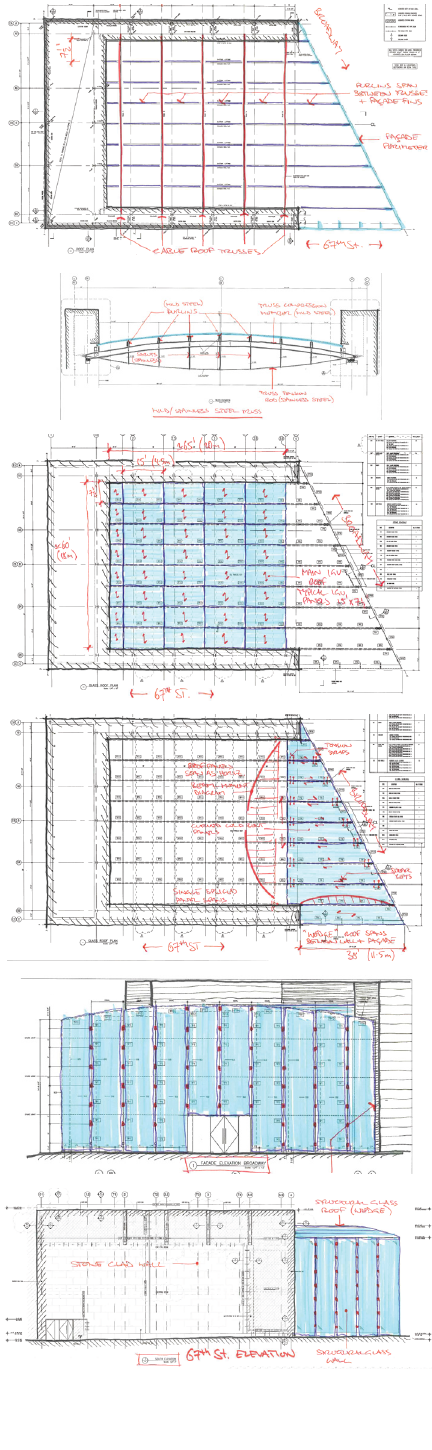
Figure 2: Structural plan. Steel trusses span 20m between the stone perimeter walls. Broadway runs diagonally from SE to NW along a 25m facade, 67 th St runs horizontally from E to W along a 12m facade. Steel purlins run between 22-33m from the back to the front of the store with a movement joint at the wedge/barrel vault interface. Figure 3: Two parallel mild steel plates, form the top chord of the truss. A single pre- stressed 38.1mm high strength “nitronic” stainless steel rod ( σ y = 1GPa) forms the bottom tension chord.